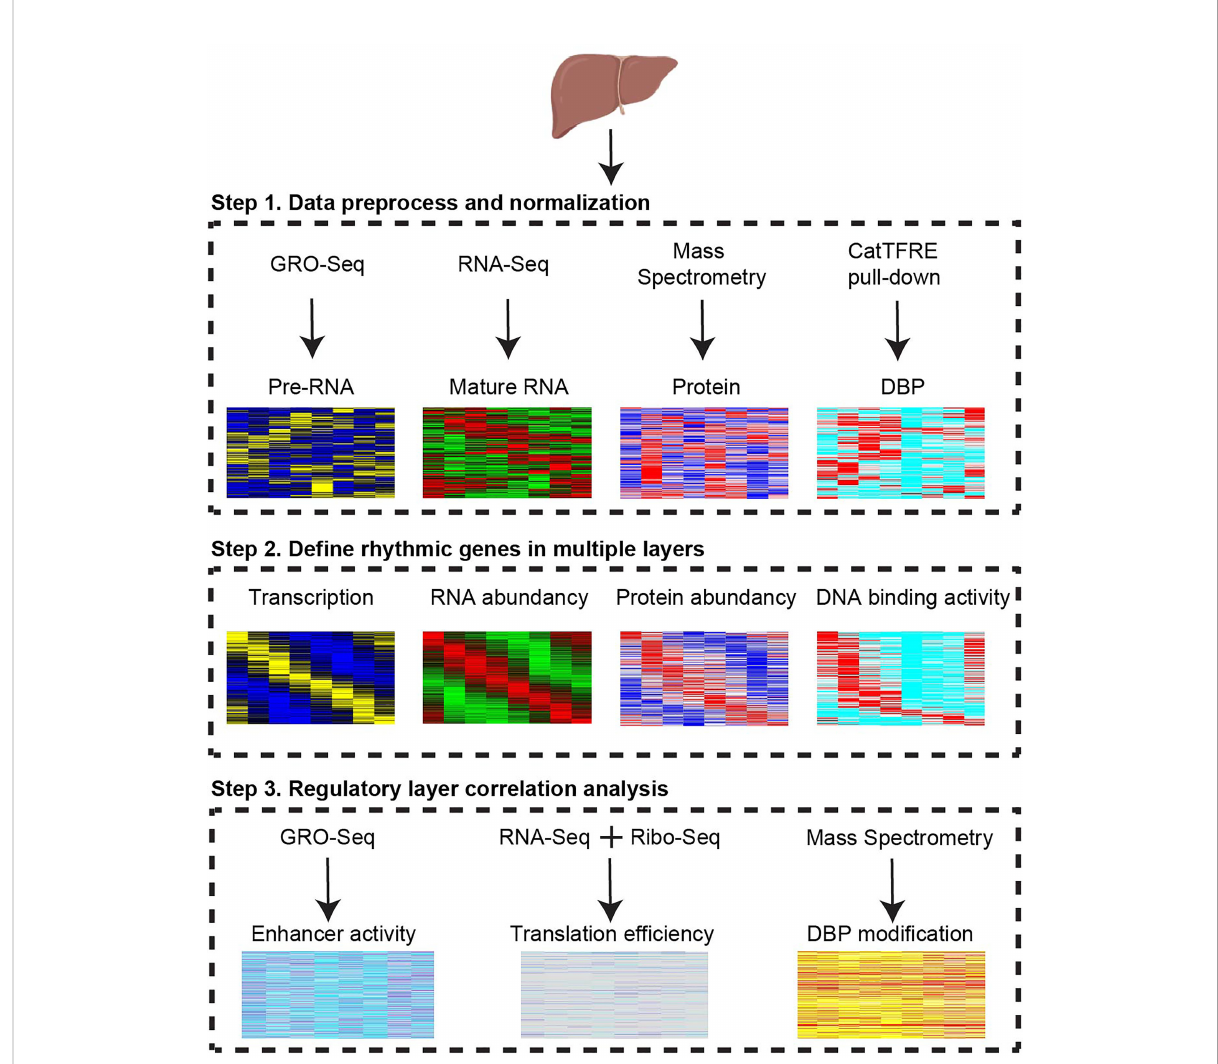
FIGURE 1 Strategy to dissect regulatory layers for diurnal gene expression. Multi-omics pro fi les from transcription, mature RNA, protein, DNA binding protein, enhancer RNA, translation rate, and phosphorylation were integrated to reveal multiple rhythmic regulatory layers. CatTFRE, concatenated tandem array of the consensus TFREs. DBP, DNA binding protein. GRO-seq, Global Run-On Sequencing. Ribo-seq, Ribosome pro fi